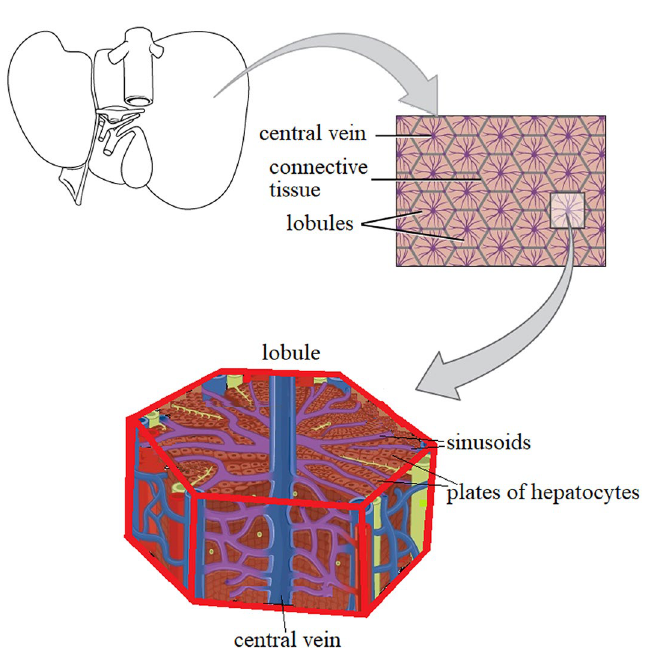
Figure 1. ( a ) The suggested trajectory towards the liver tumor; ( b ) Honeybee barbed needle inspired from 1,2 .